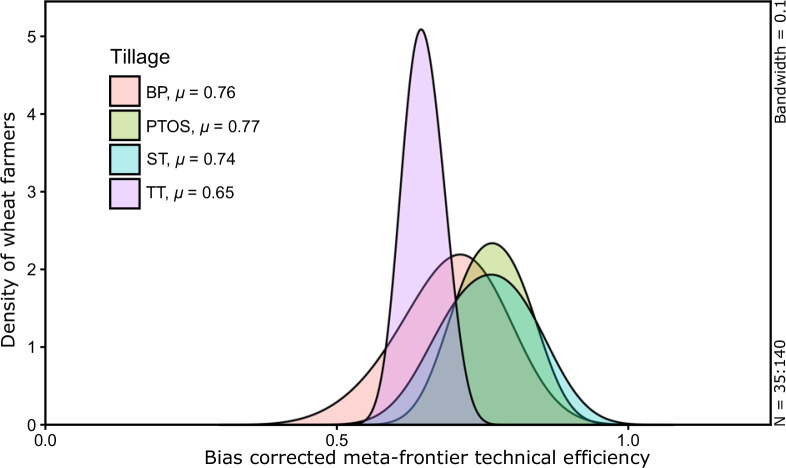
Epanechnikov kernel density estimates of bias corrected meta-frontier
TE of tillage options. ‘μ’
denotes the mean values of bias corrected meta-frontier TE. Density
curves with pink, green, blue and purple filled area show bias
corrected meta-frontier TE of BP, PTOS, ST and TT respectively
(color figure online)